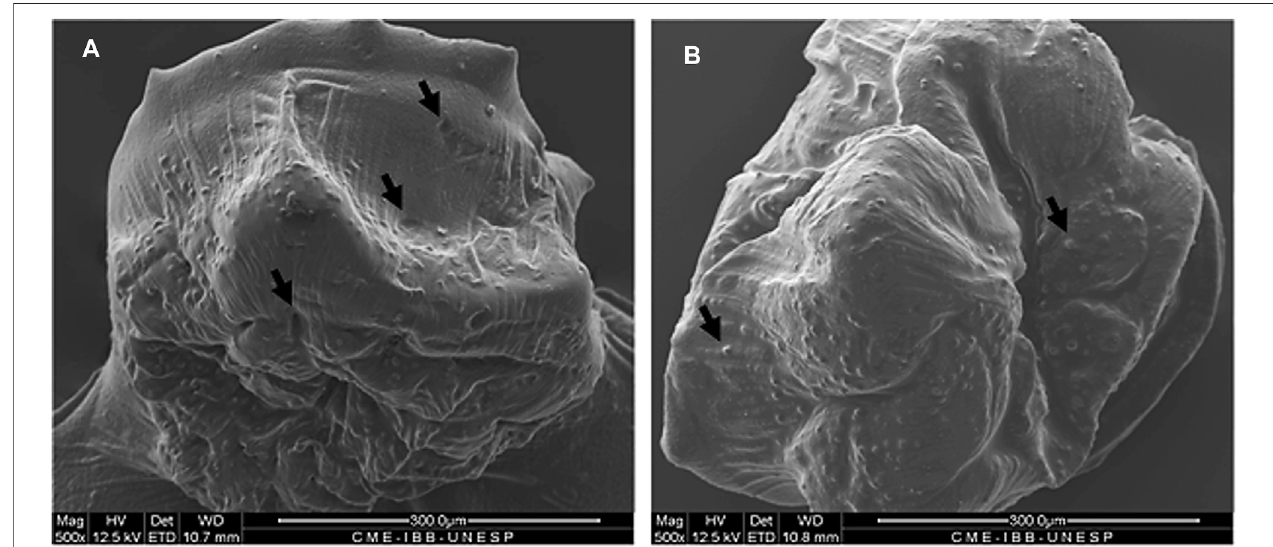
FIGURE2| SEManalysisofcapsules withMSCsshowingthecapsulesurface,pores andsuper fi cialMSCs.Blackarrows indicatepores (A) and MSCsentrapped in the alginate network (B) . Magni fi cation of 500x.